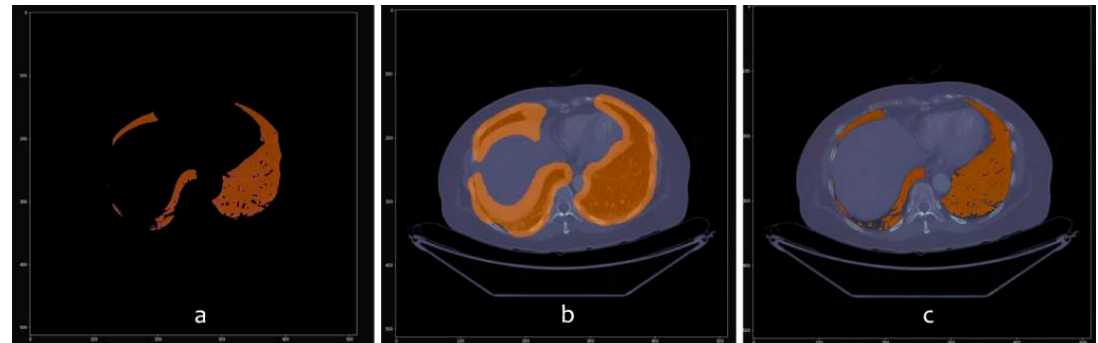
Figure 9. ( a ) Overlap to compare mask before (purple) and after (orange) threshold filtering (left), ( b ) dilation filter (middle), and ( c ) the result of erosion: final mask (right).